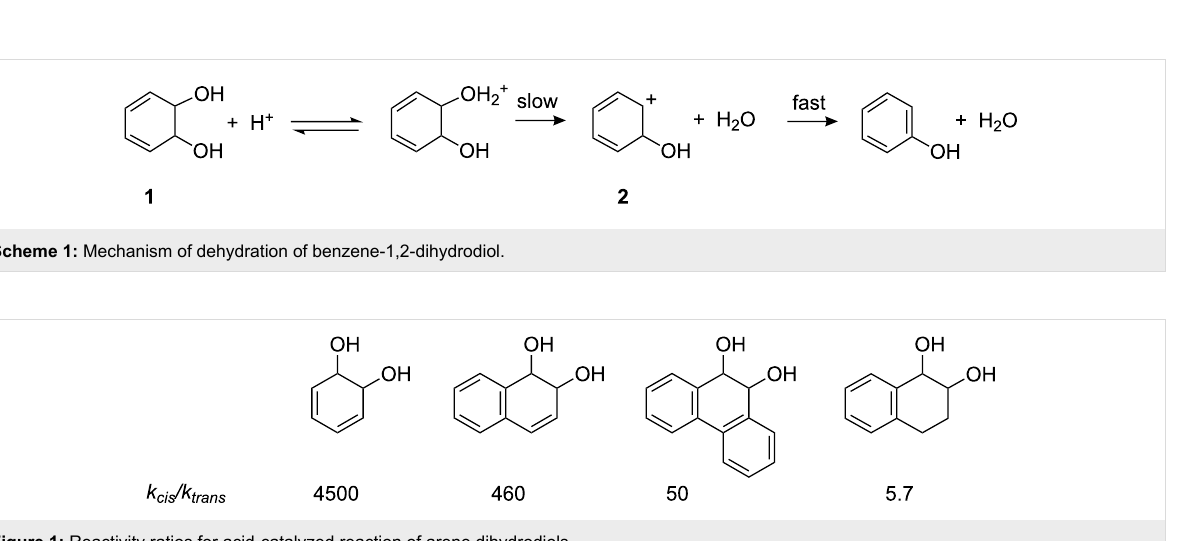
diols of non-aromatic double bonds for which only a small advantage for the cis -diol is observed. Indeed, the cis / trans rate ratio decreases regularly as the aromaticity of the double bond decreases, as shown for the dihydrodiols of benzene, naphtha- lene (1,2), phenanthrene (9,10) and 3,4-dihydronaphthalene in Figure 1 [3].